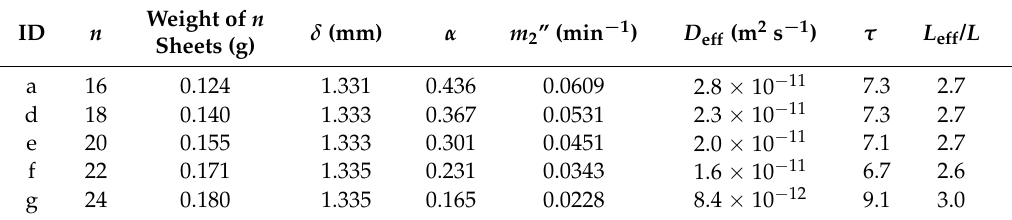
Table 4. Effect of compression ratio on parameters 1 of methylene blue elution.